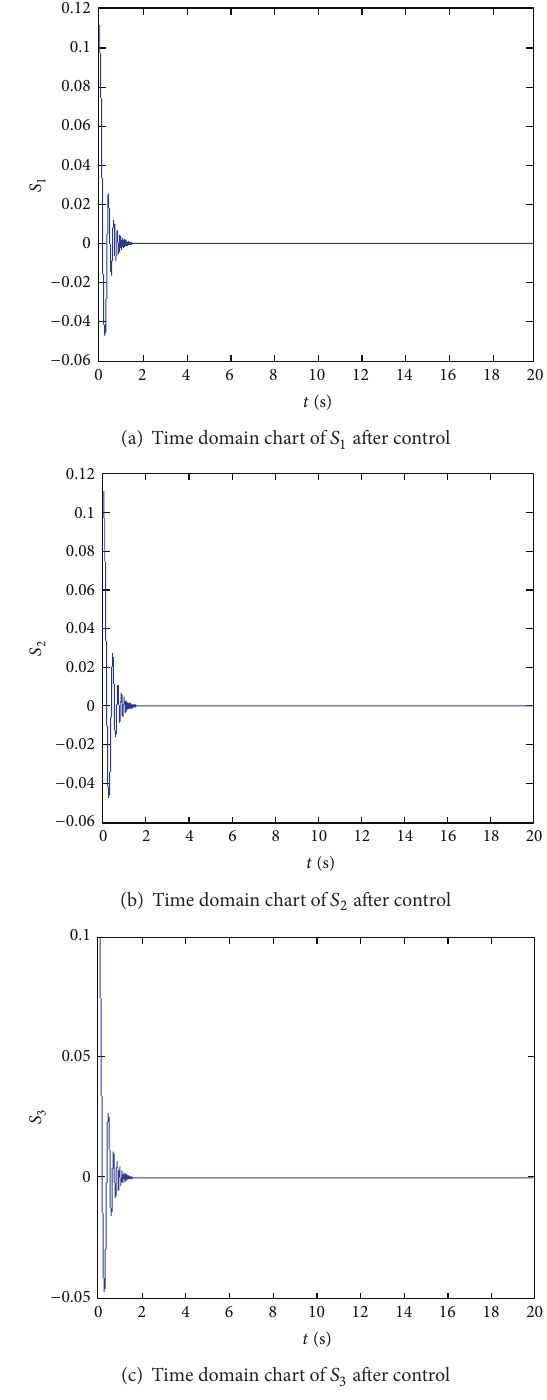
Figure 12: Time domain charts of state variables after control. Figure 13: Time domain charts of sliding surfaces after